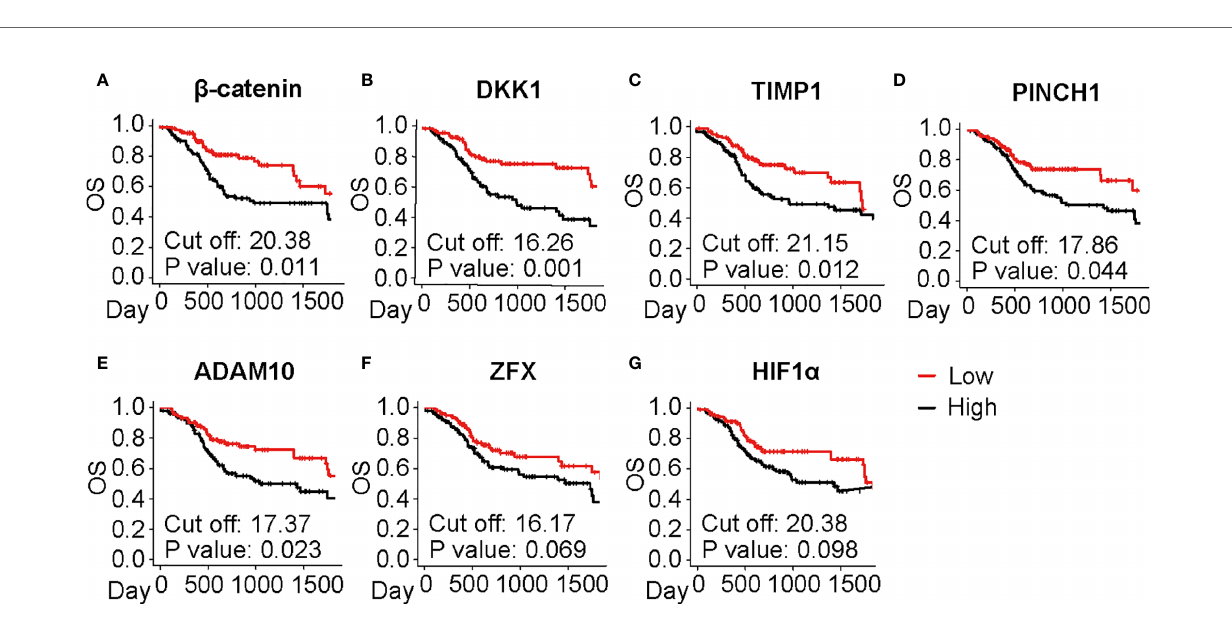
FIGURE 4 | Prognostic signi fi cance of the selected IHC biomarkers identi fi ed by the systematic review and meta-analysis. (A – G) Kaplan-Meier analyses of overall survival (OS) in the laryngeal and pharyngeal HNSCC cohort of the Cancer Genome Atlas (TCGA) (N = 205) strati fi ed by gene expression of the identi fi ed biomarkers are shown. Median is used for the cutoff values. Statistical signi fi cance is determined using log-rank